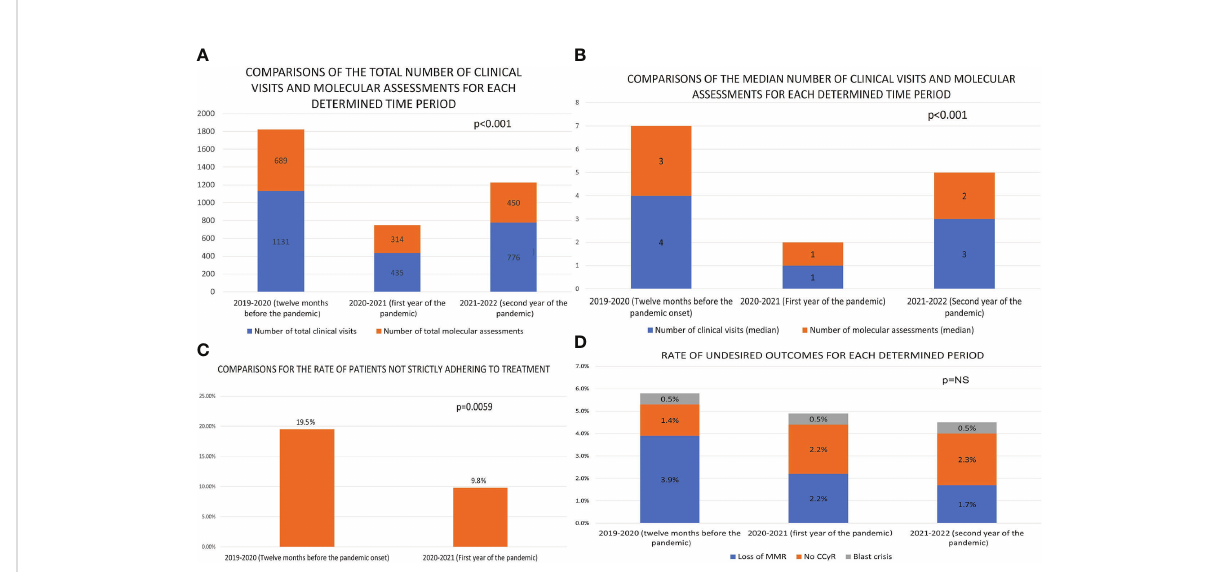
FIGURE 1 The comparisons of selected features between the twelve months prior to the pandemic and the fi rst twelve months of the pandemic [ (A) The comparison of the total number of clinical visits and molecular assessments of CML-CP patients at the institution. (B) The comparison of the median number of clinical visits and BCR::ABL1 IS PCR testing for follow up of CML-CP patients at the institution. (C) The comparison of the ratio of TKI-incompliance among CML-CP patients at the institution. (D) The comparison of the number and ratio of patients who have lost major molecular response (MMR) and those who have lost or not achieved the equivalent of complete cytogenetic response (NS, not signi fi